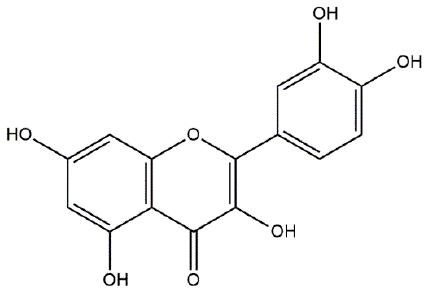
Figure 22. Schematic representation of quercetin’s chemical structure.